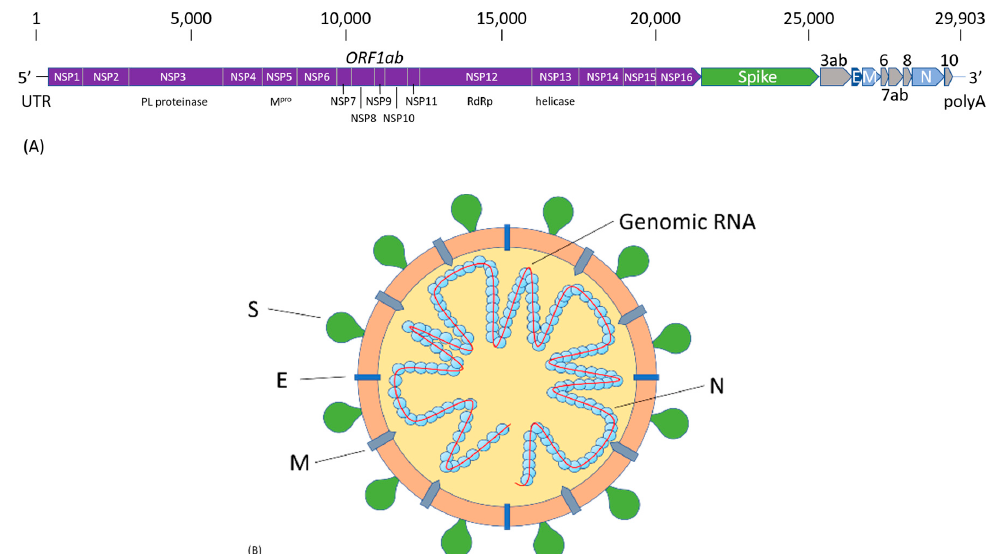
overlapping polyproteins, PP1a, consisting of NSP1-11, and PP1ab, consisting of NSP1-16, with the exception of NSP11, which is part of NSP12 in PP1ab. The rest of the ORFs encode the four structural proteins, S, E, M, and N, and several accessory proteins with unknown functions. ( B ) Structure of SARS-CoV-2 virion. The lipid bilayer. embedded with S, E, and M proteins, capsulizes the single-stranded genomic RNA, which is stabilized by the N protein. The S protein is responsible for the recognition of host cell ACE2 receptor to gain cell entry.